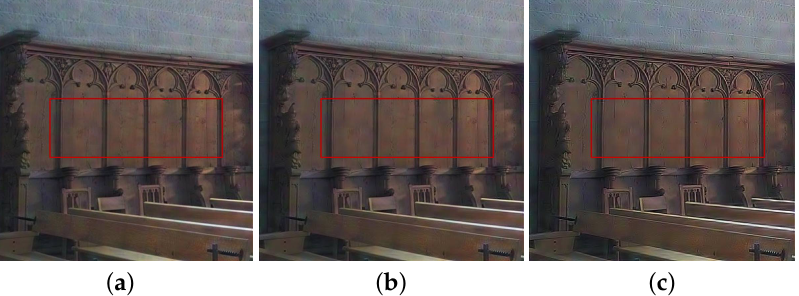
Figure 15. Fusion results from the MFD framework with different η in the denoising term for fused RGB image. ( a ) η = 0.001. ( b ) η = 0.005. ( c ) η =